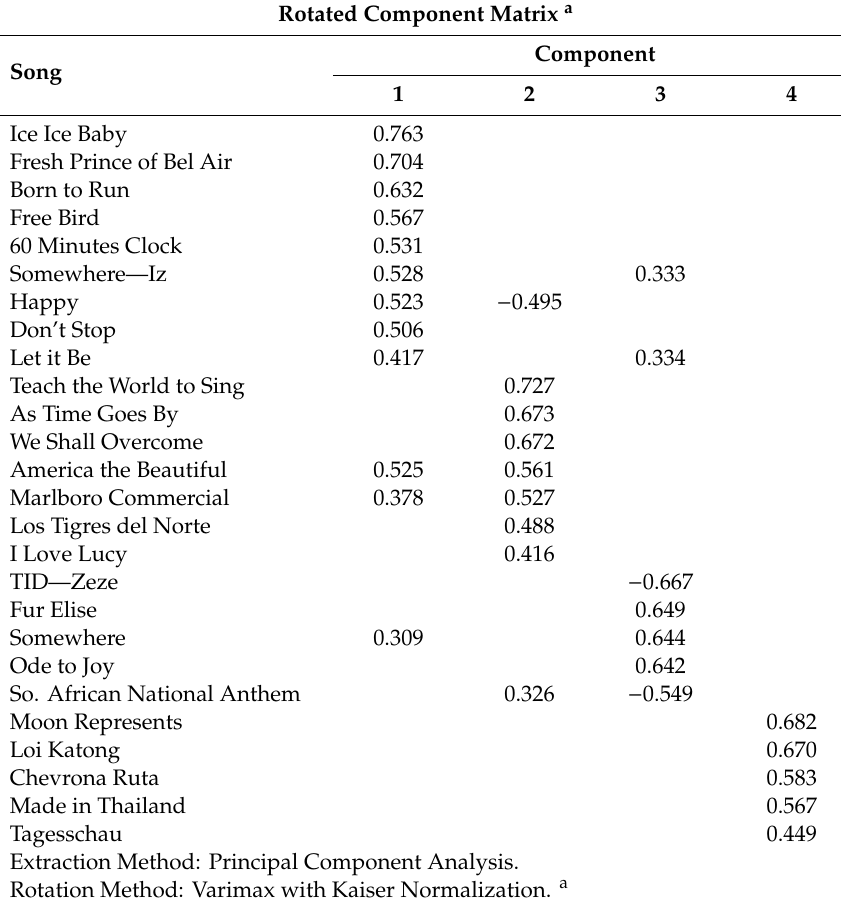
Table 1. Analysis 4 component